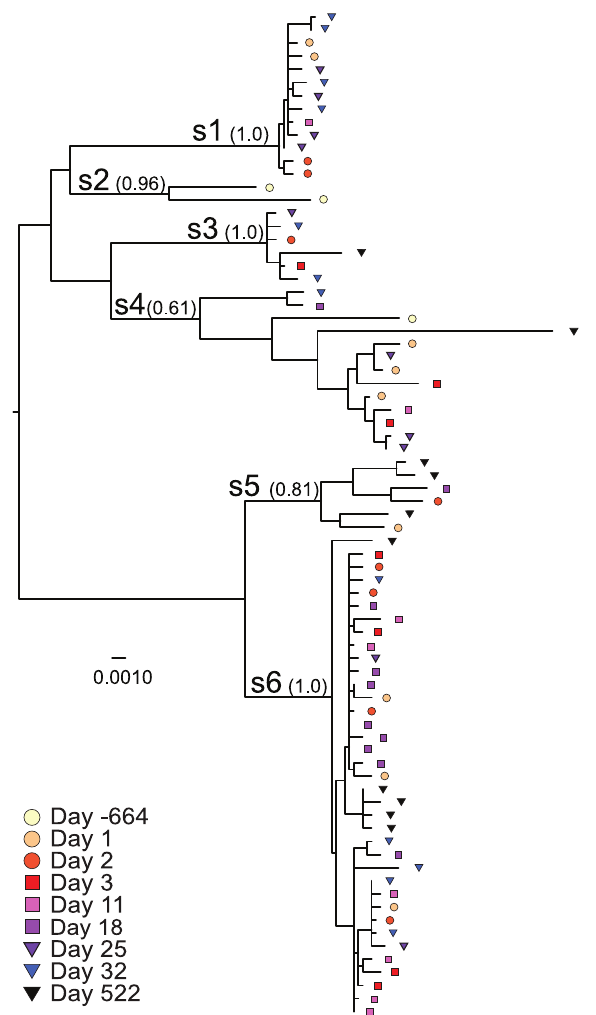
Figure 1. Maximum likelihood tree of the phylogenetic relationships of the viral subpopulations. Sequences from the different time points (in days from day 1) are indicated with different symbols and colors as shown. The subpopulations are labeled with letters s1–s6 and the corresponding bootstrap values are shown as ratios of 1000